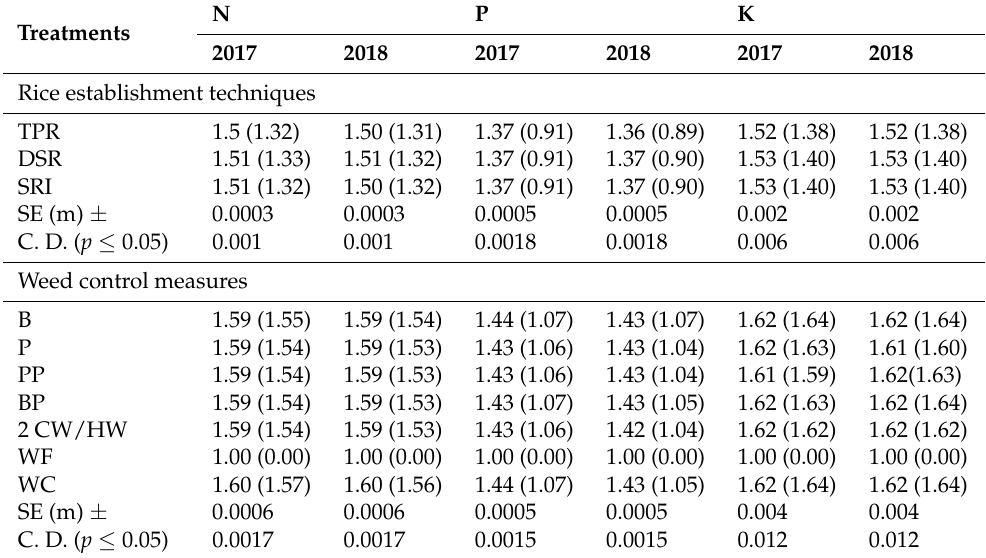
Table 7. Influence of rice establishment techniques and weed control measures on nutrient con centration (%) of